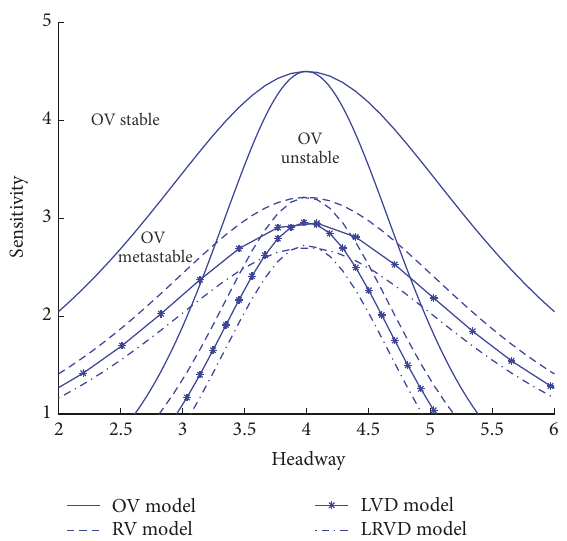
Figure 2: Neutral stability curves and coexisting curves of OV, RV, LVD, and LRVD models.